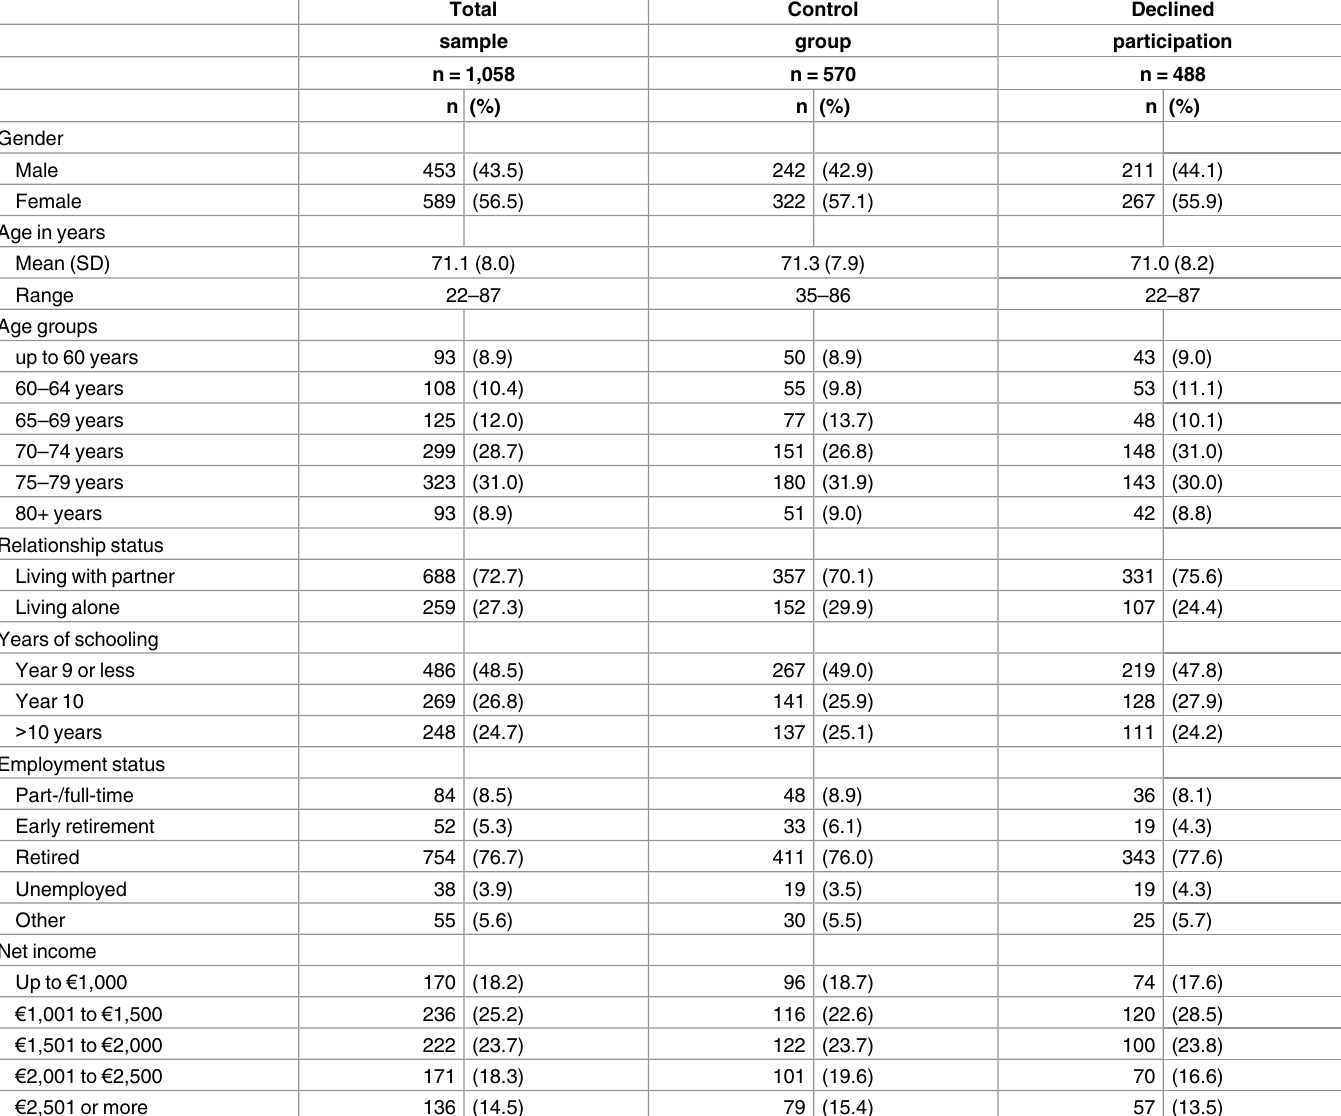
Table 1. Sociodemographic characteristics of the sample; total sample and comparison of control group (n = 570) versus those who declined par- ticipation (n =